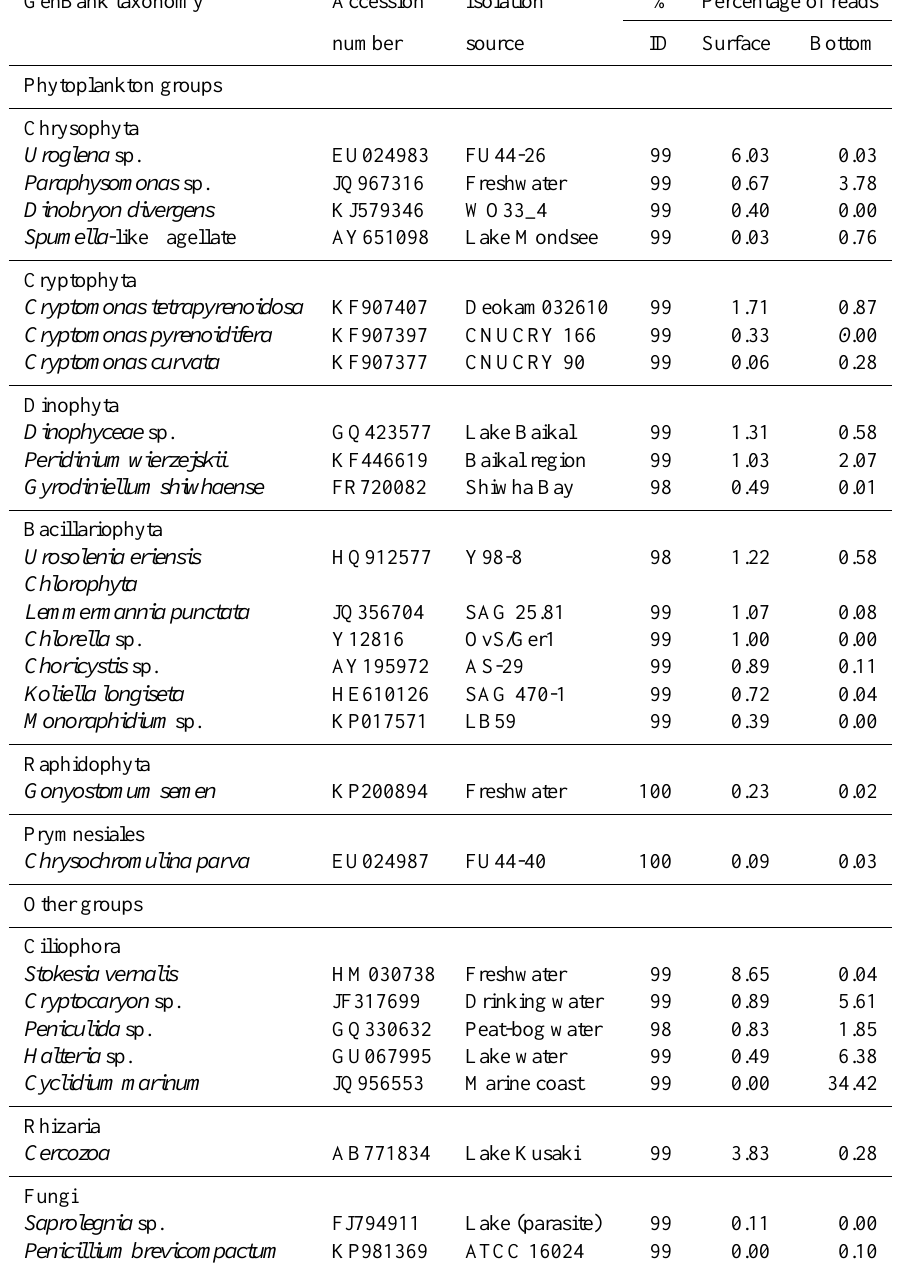
Table 5. Closest identity (ID) of eukaryotic RNA sequences from permafrost thaw lake SAS2A to GenBank sequences (following a BLASTn search), at the lowest taxonomic level